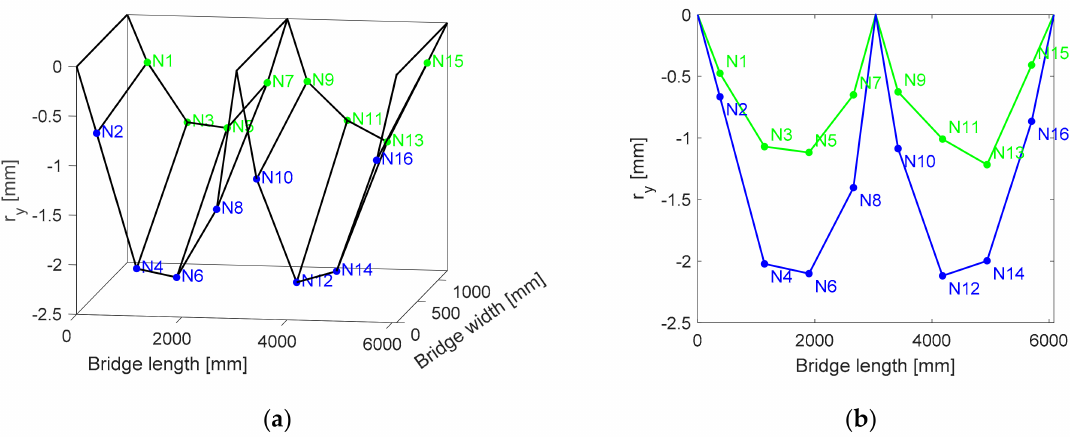
Figure 7. D ( a ) and 2D ( b ) plots of the r values for all of the nodes for the baseline